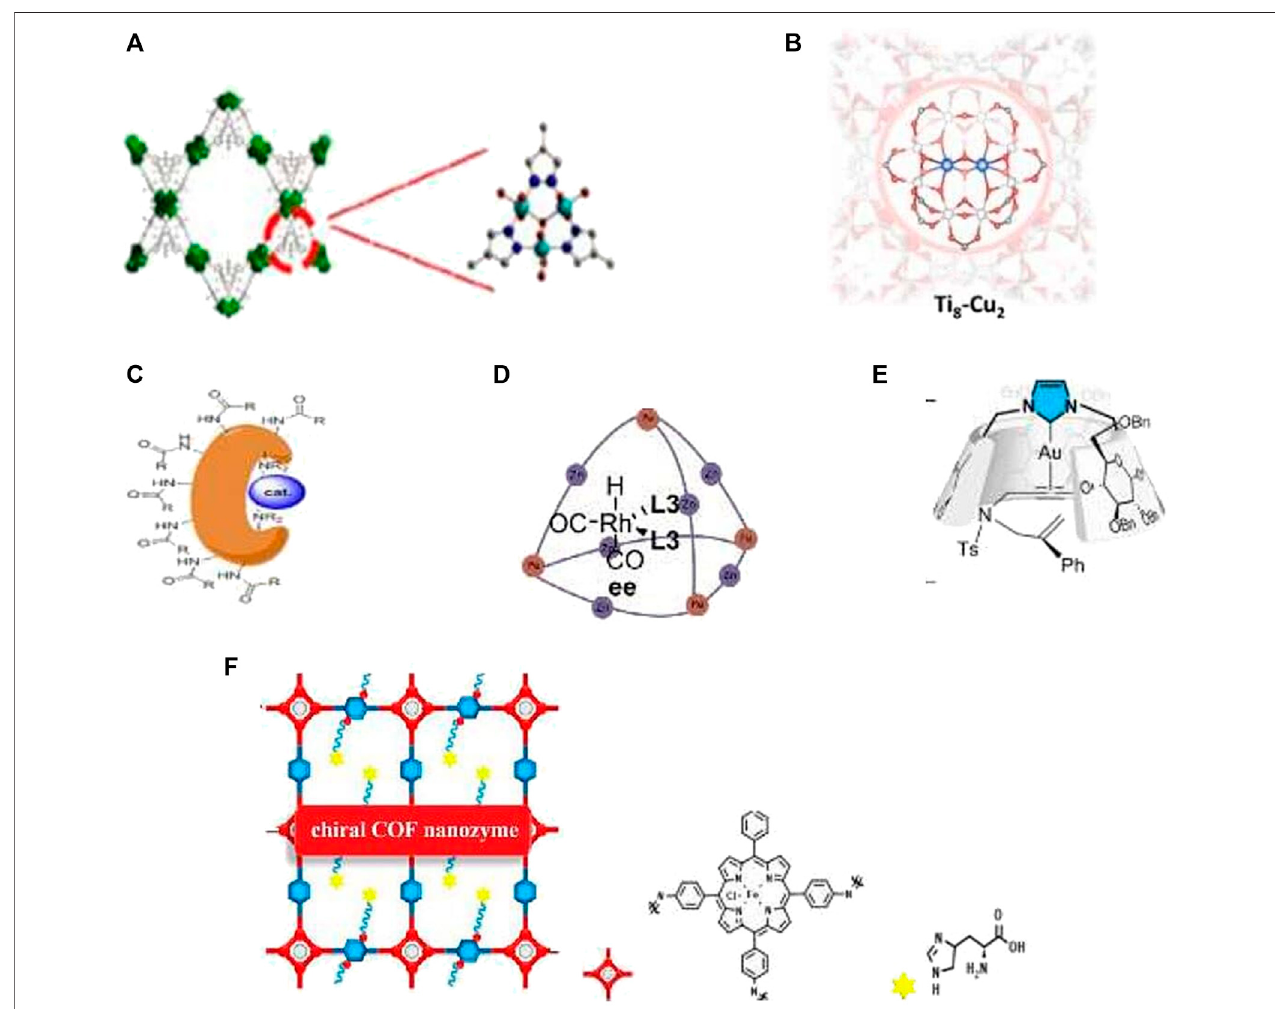
FIGURE1| IMC asbioinspiredcatalysts: (A) Arti fi cial catechol oxidase (Liet al,2020). (B) Arti fi cial binuclear copper monooxygenase based onTi-MOF(Feng et al, 2021). (C) MC (cat-RuOs) for enantioselective dihydroxylation and epoxydation of styrene derivatives (Leurs et al, 2018). (D) MC for the alkene size-selective hydroformylation (Nurttila et al, 2019). (E) N-heterocyclic carbene-capped CD-Au complex for an enantioselective enyne cycloisomerization (Roland et al., 2018). (F) Chiral COF nanozyme for enantioselective L-DOPA oxidation (Zhou et al,